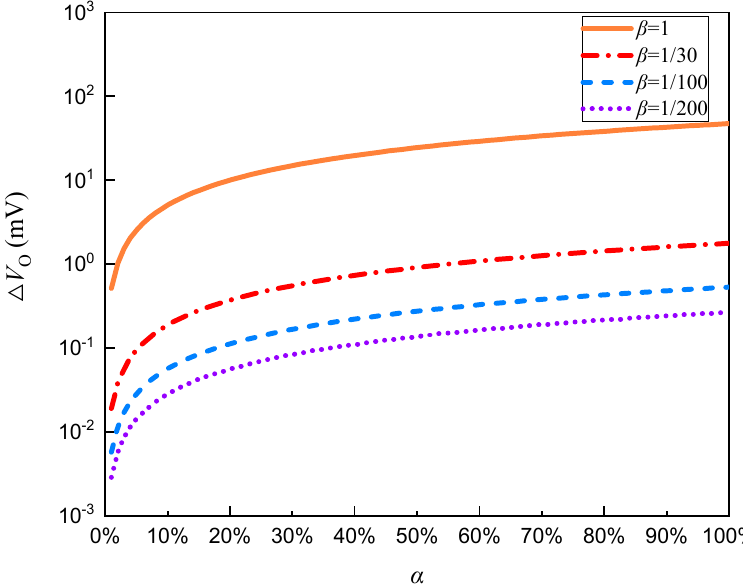
the impedance mismatch of two acquisition electrodes. Therefore, a noise neutralization method is proposed to solve above di ffi culties.